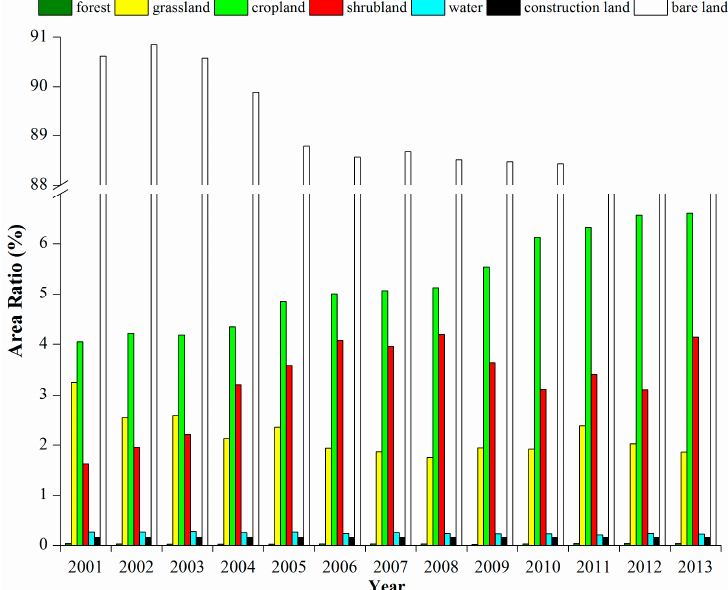
Figure 3. Changes in land cover within the study area from 2001 to 2013.